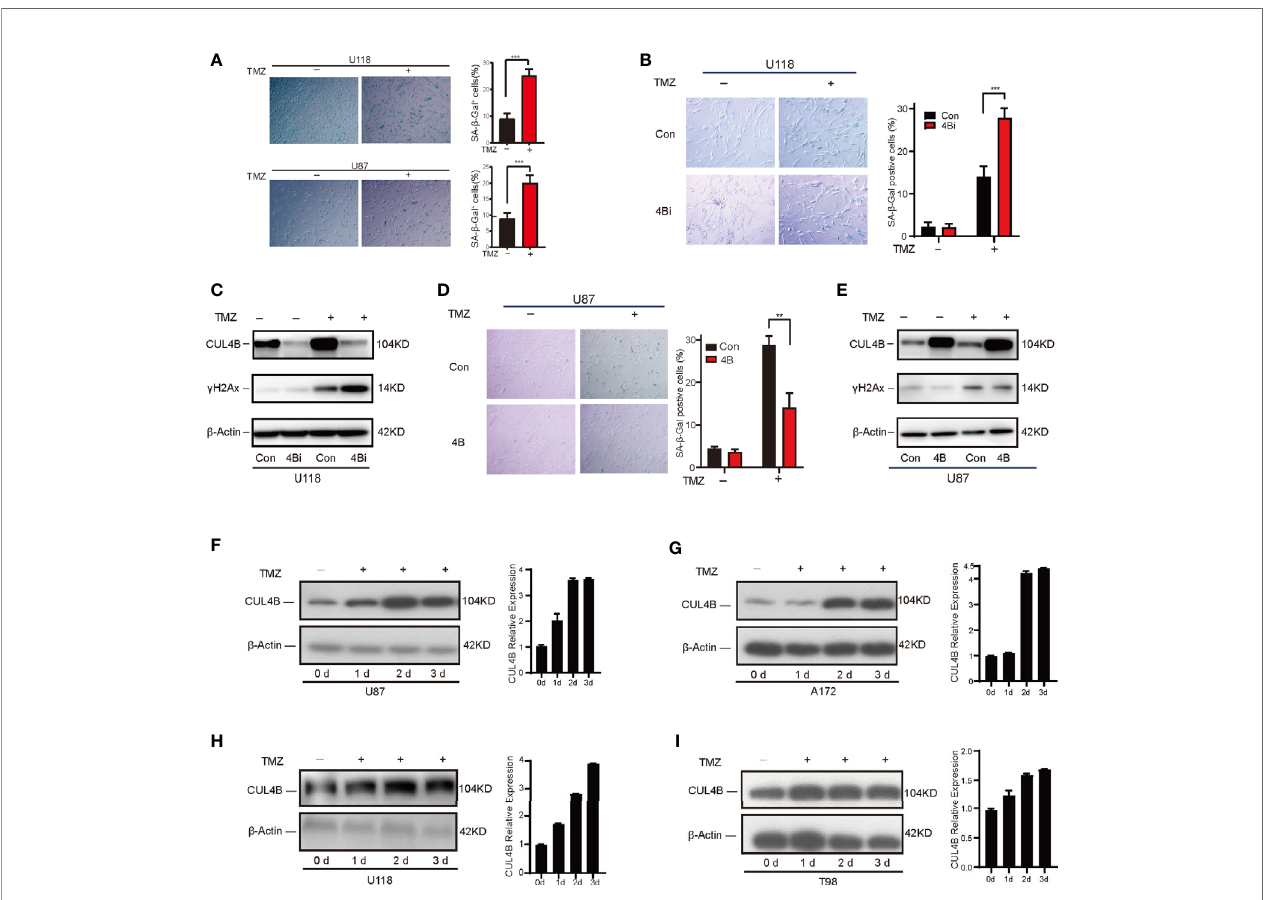
FIGURE 4 | CUL4B suppresses TMZ-induced senescence. (A) Senescence induced by TMZ in U118 cells (300 m M) and U87 cells (100 m M) after 5 days treatment. (B, C) SA- b -galactosidase staining (B) and g H2Ax levels (C) in U118 control and 4Bi cells with and without TMZ (300 m M) after 3 days treatment. (D, E) SA- b - galactosidase staining (D) and g H2Ax level (E) in indicated U87 cells treated with and without TMZ (100 m M) after 3 days treatment. (F, G) TMZ-sensitive U87 (F) and A172 (G) cells harvested on 0, 1, 2, and 3 days after TMZ addition (100 m M). Quanti fi cations of CUL4B expression are shown in the histogram. (H, I) TMZ-resistant U118 (H) and T98 (I) cells harvested on 0, 1, 2, and 3 days after TMZ addition (300 m M) and the protein levels of CUL4B were detected. (***P < 0.001, **P <